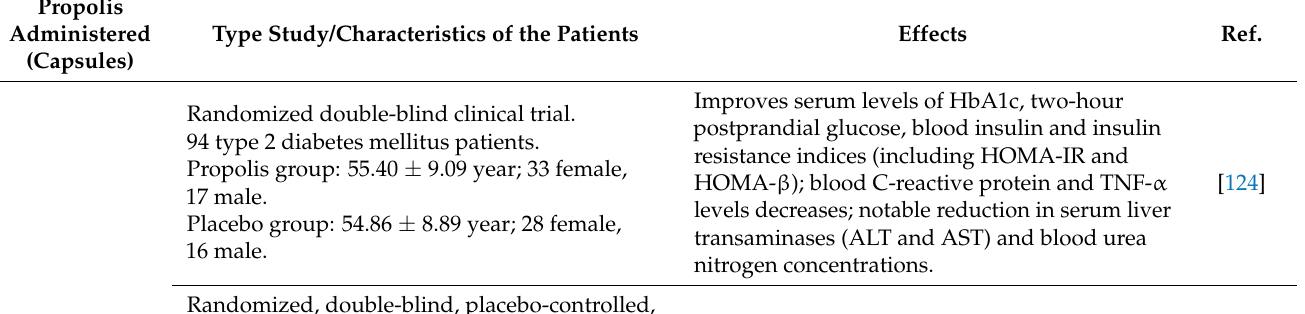
Table 4. Studies on the effect of propolis administration in patients with type 2